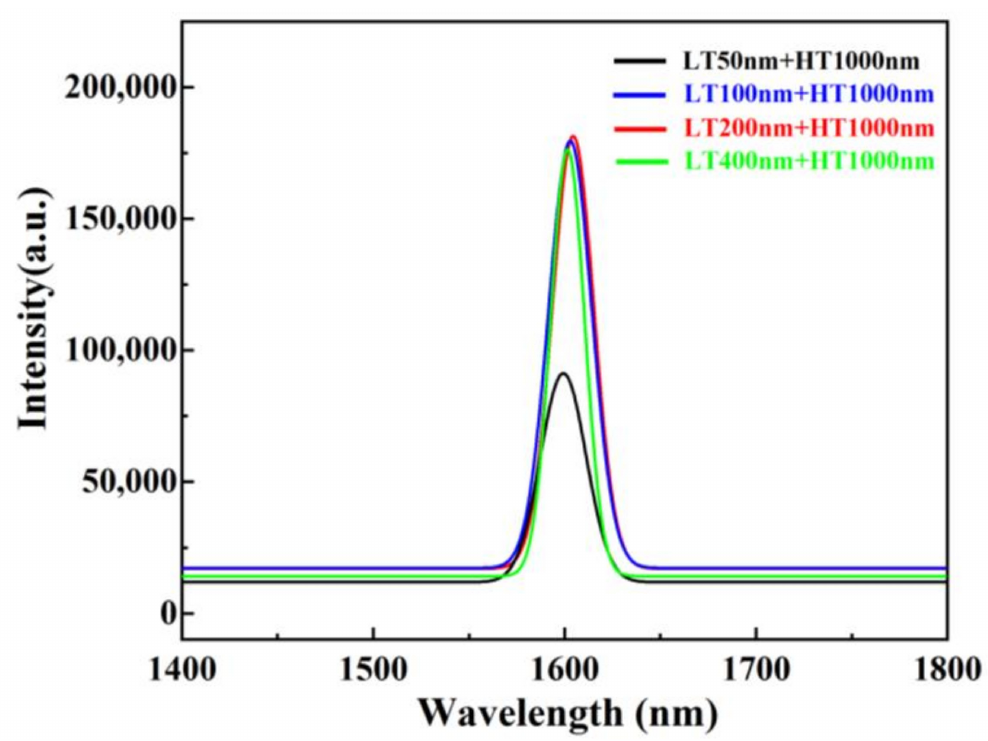
Figure 8. Room temperature of photoluminescence spectrum of two-step grown Ge layers using different thicknesses of LT Ge buffer.